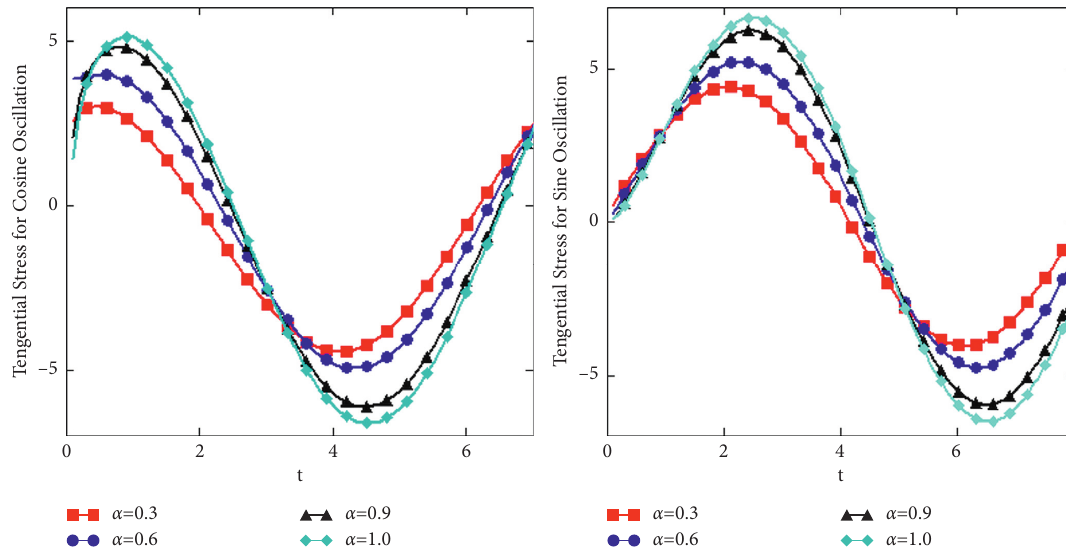
Figure 8: The variation of α for both the oscillations with ω � π /4, λ